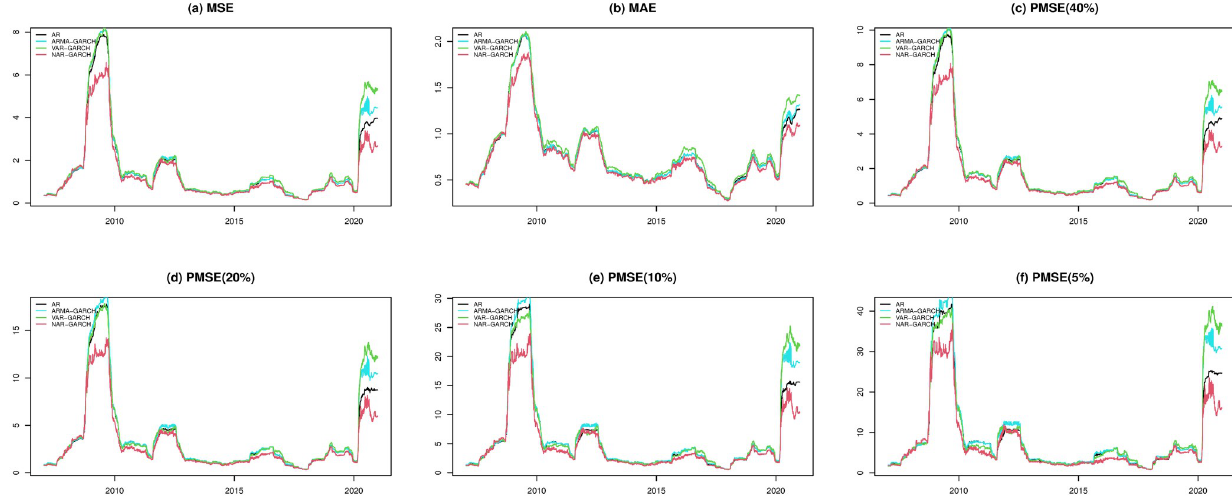
Fig 2. The fitted performances of the 4 models for the S&P 500